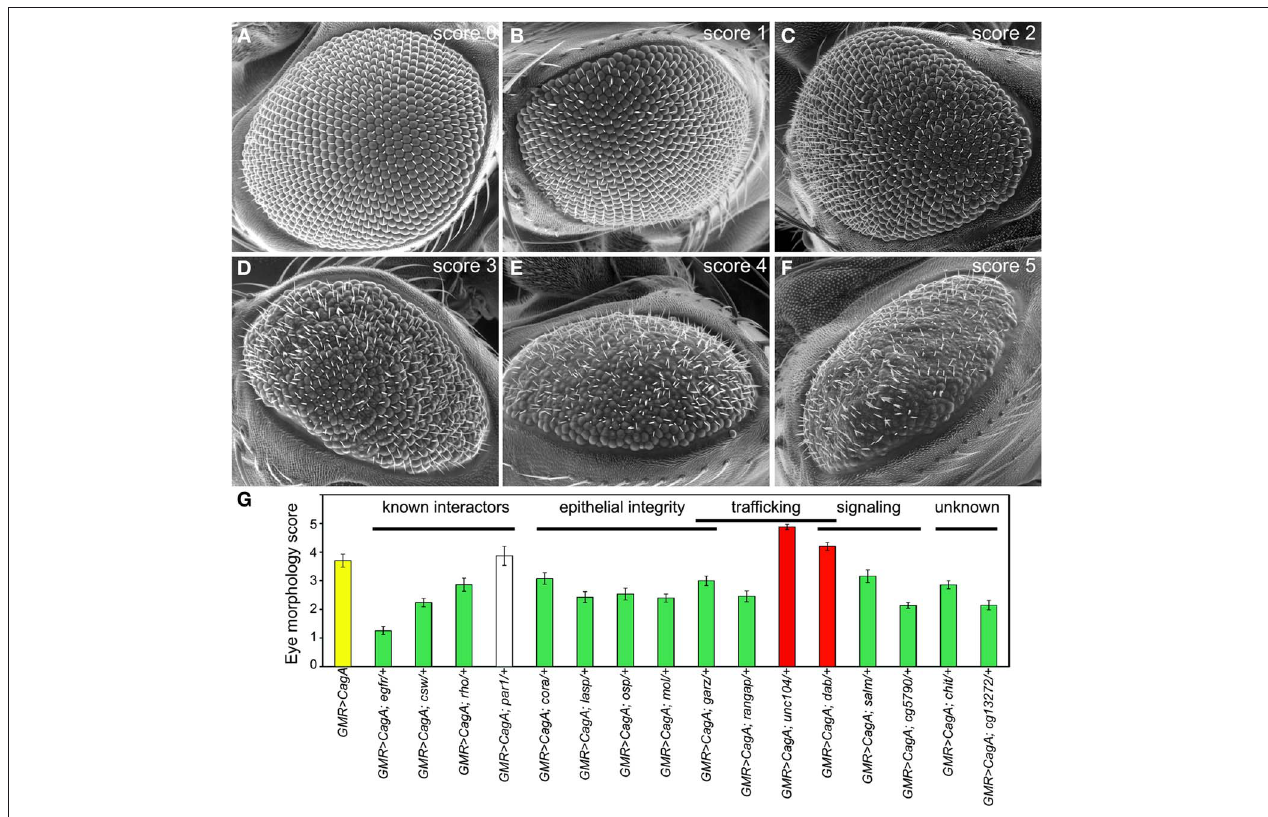
FIGURE 2 | (A–F) Representative ESEM images for each class of disruption by CagA. The scoring rubric is described in Materials and Methods. (G) The mean ESEM-based eye disruption for CagA, known interactors and Moc genes of different functional classes. Error bars represent standard error.